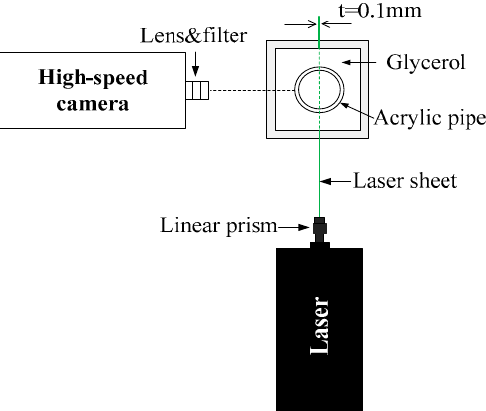
Figure 2. Sketch of planar laser-induced fluorescence system for flow visualization.